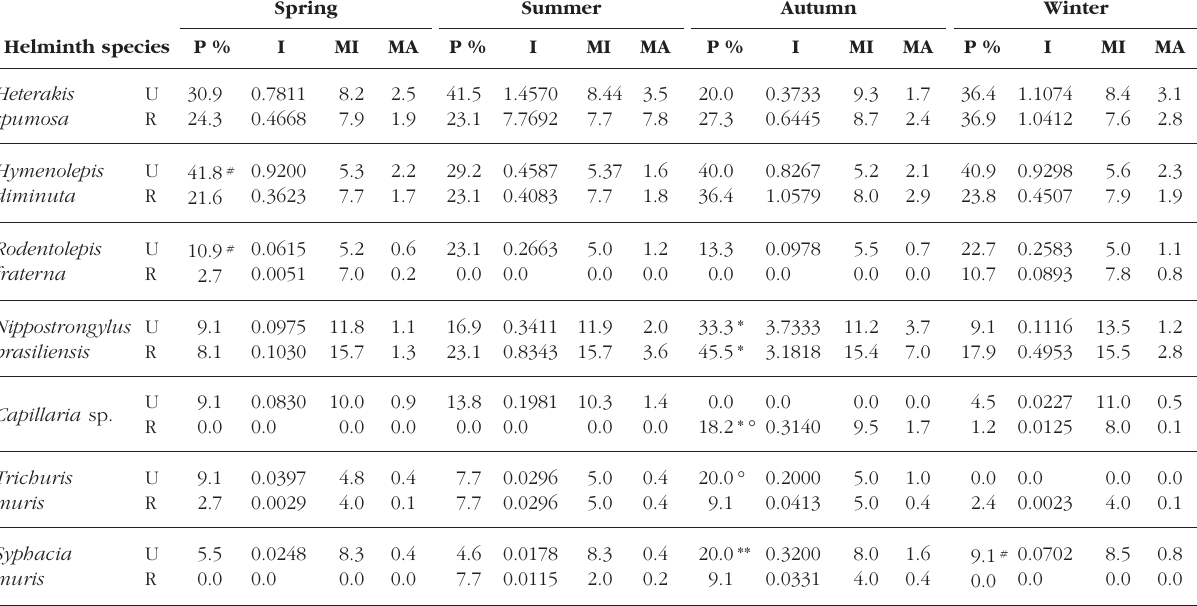
Table III. – Seasonal quantitative indices of individual intestinal helminth infection of Rattus norvegicus